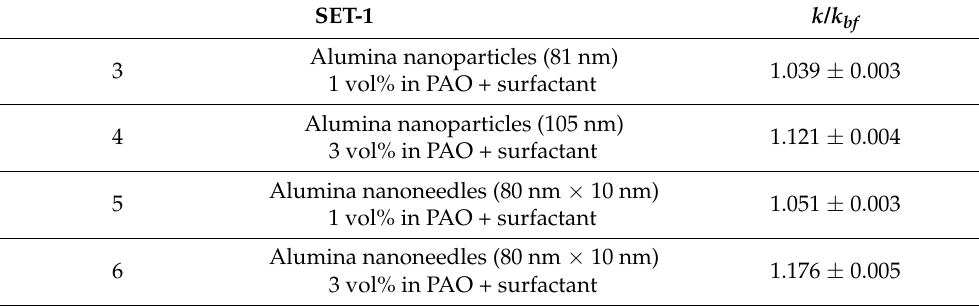
Table 1. Features of the samples of SET-1 and experimental data